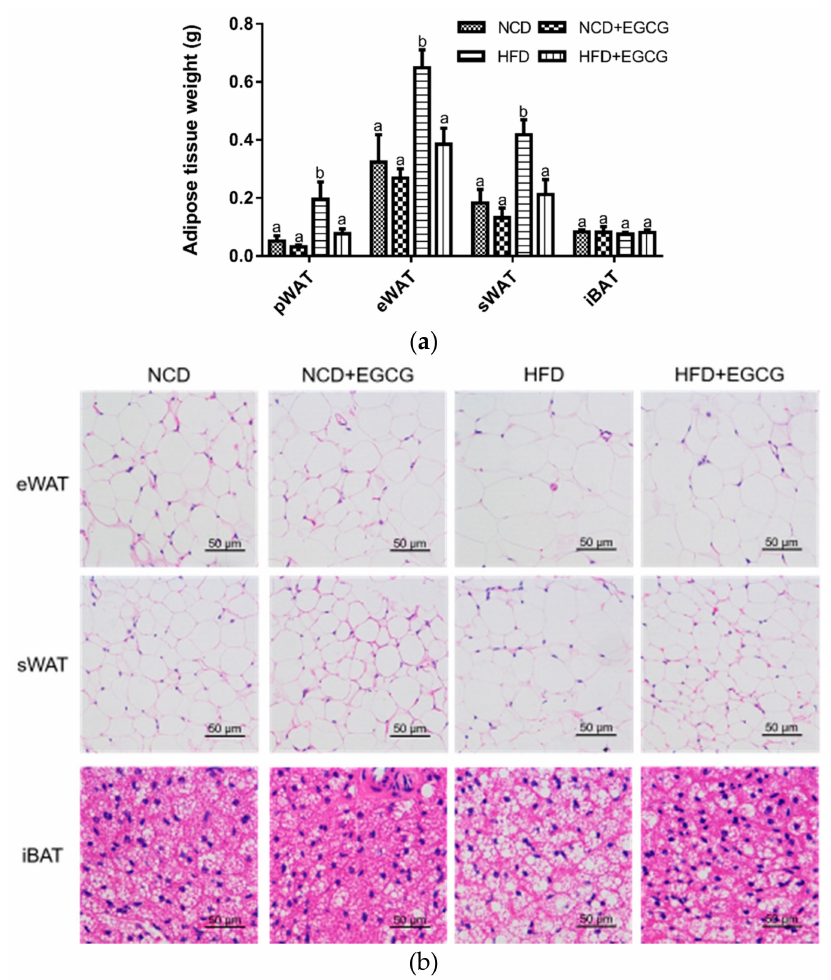
Figure 1. Effect of EGCG on adipose tissue. ( a ) Weight of pWAT, eWAT, sWAT and iBAT; ( b ) Representative hematoxylin and eosin (H&E) staining from eWAT, sWAT and iBAT sections. Data are shown as mean ± SD ( n = 8). Mean values with different letters (a and b) are significantly different ( p <